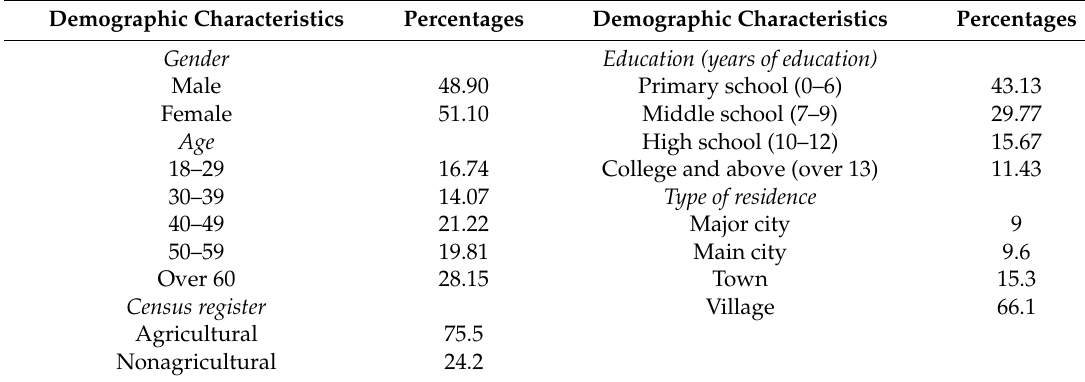
Table 1. Demographic statistics of the